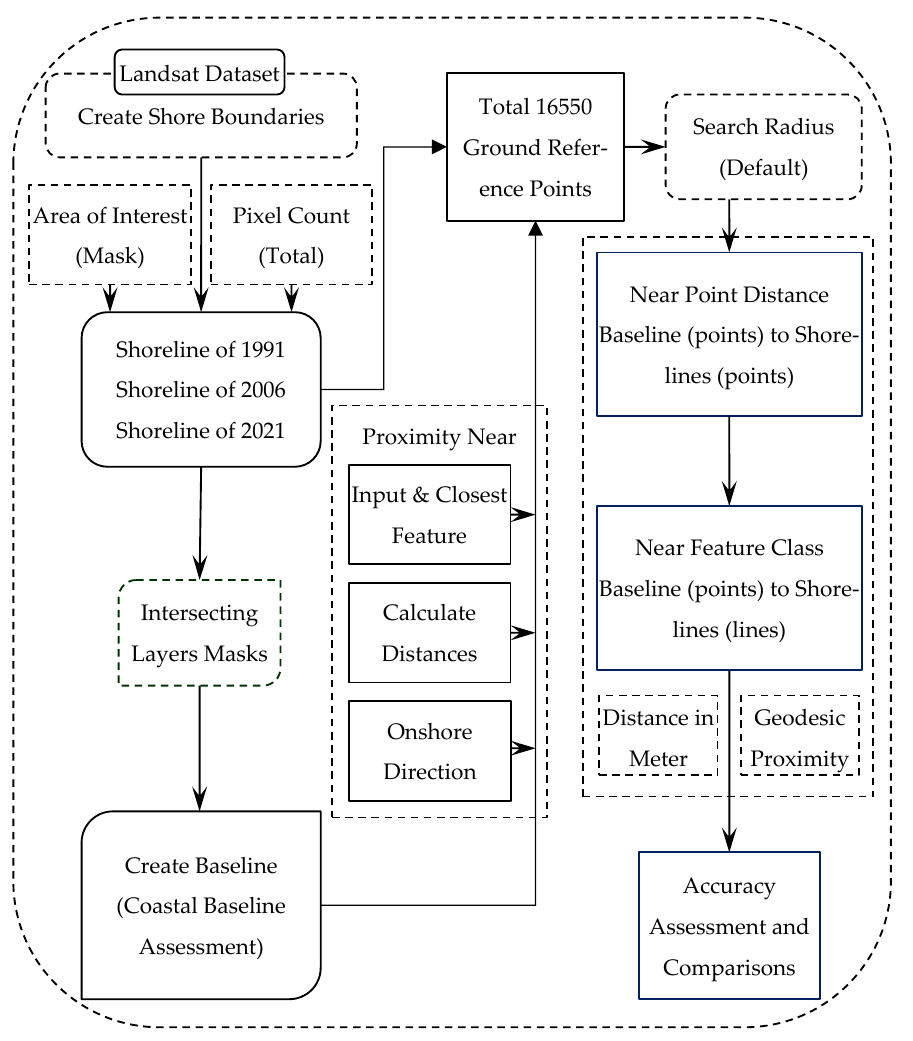
Figure 3. Proximity analysis of the study.